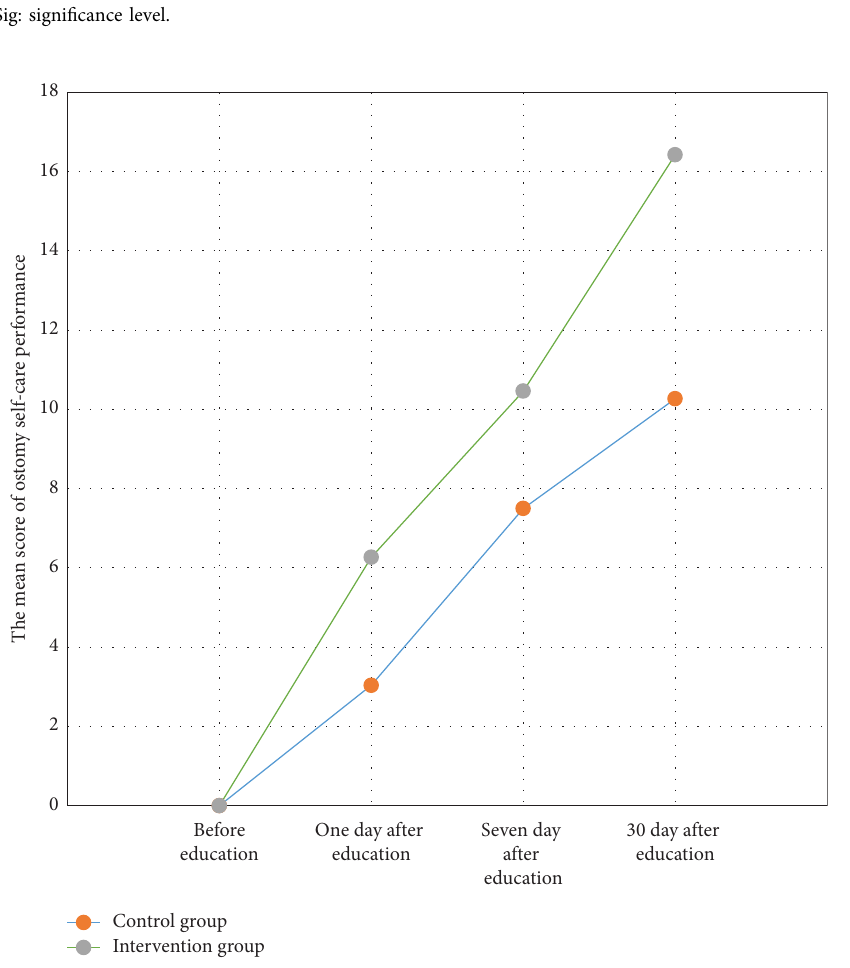
Figure 2: Te mean score of ostomy self-care performance in diferent distinct